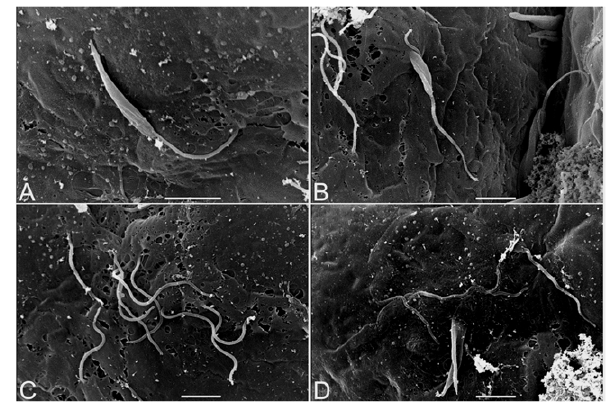
Figure 2. Scanning electron microscopy of Oncopeltusfasciatus salivary glands infected with Phytomonasserpens . The parasites were injected laterally into the thorax of the insects and the salivary glands were explanted at different time points after injection. ( A ) Outer surface of the salivary gland showing a high number of parasites between two salivary gland lobes and a few parasites attached to the gland, 48 h post-infection. Scale bar: 10 m m. ( B–C ) Large numbers of parasites bound to the salivary gland, 72 h post-infection. Scale bars: 100 m m ( B ) and 50 m m ( C ). SG: salivary gland; P: parasite; SGL1, SGL2 and SGL3: salivary gland lobes. The asterisk (*) indicates the salivary duct. For further details see the Methods.